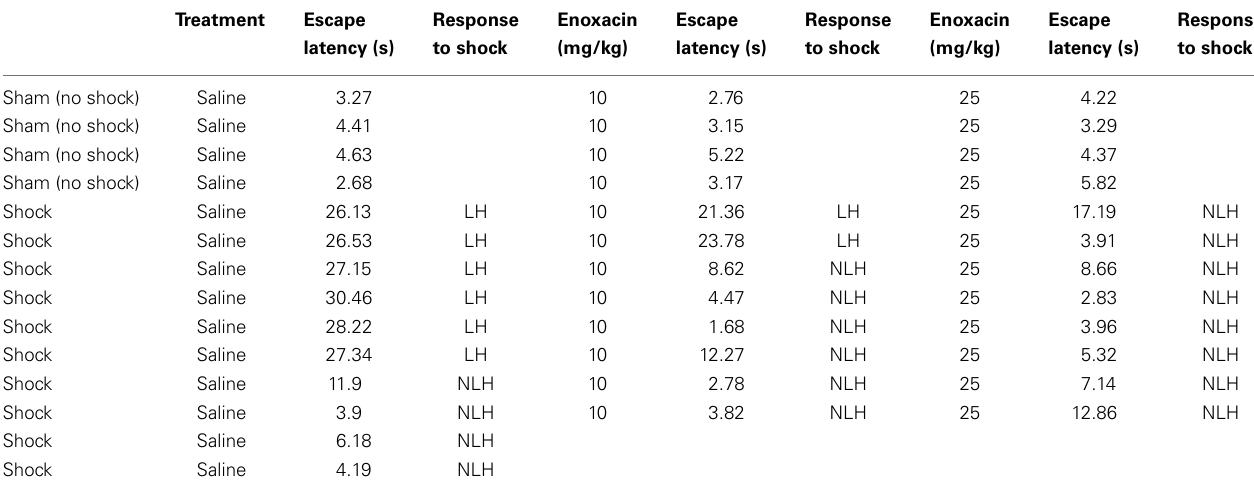
Table 2 | Escape latency of individual rats when given no shock or inescapable shock and simultaneously treated with saline or enoxacin (10 or 25mg/kg)